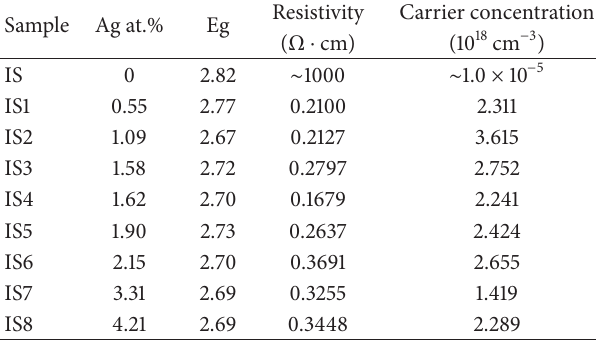
Table 1: The optical and electrical properties of the In deposited with different dopant levels.